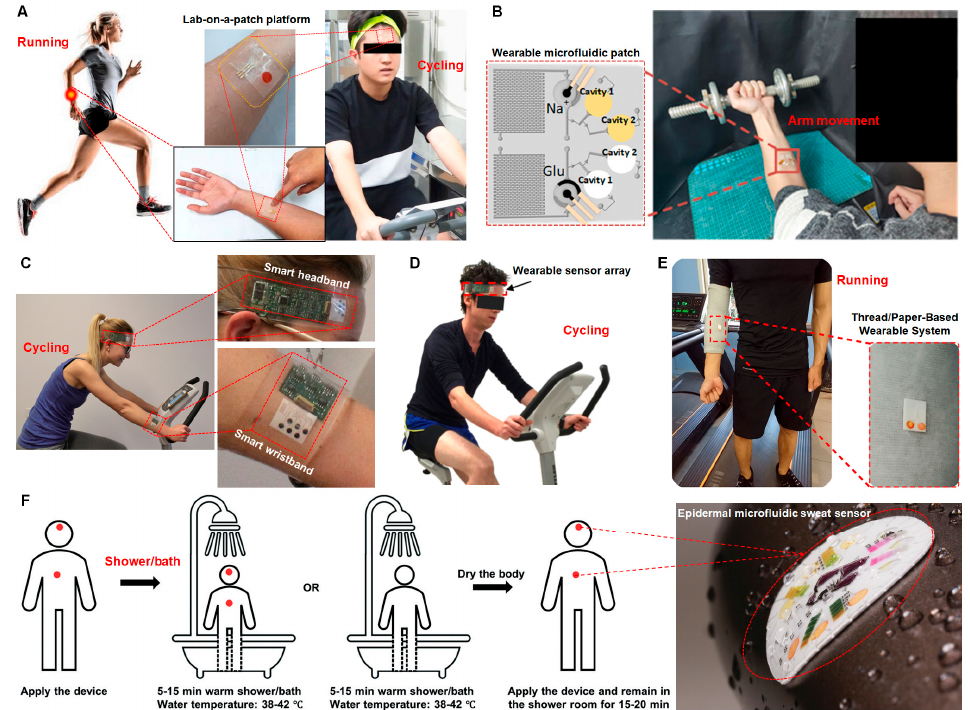
Figure 2. Epidermal wearable biosensors for passive sweat extraction through strenuous